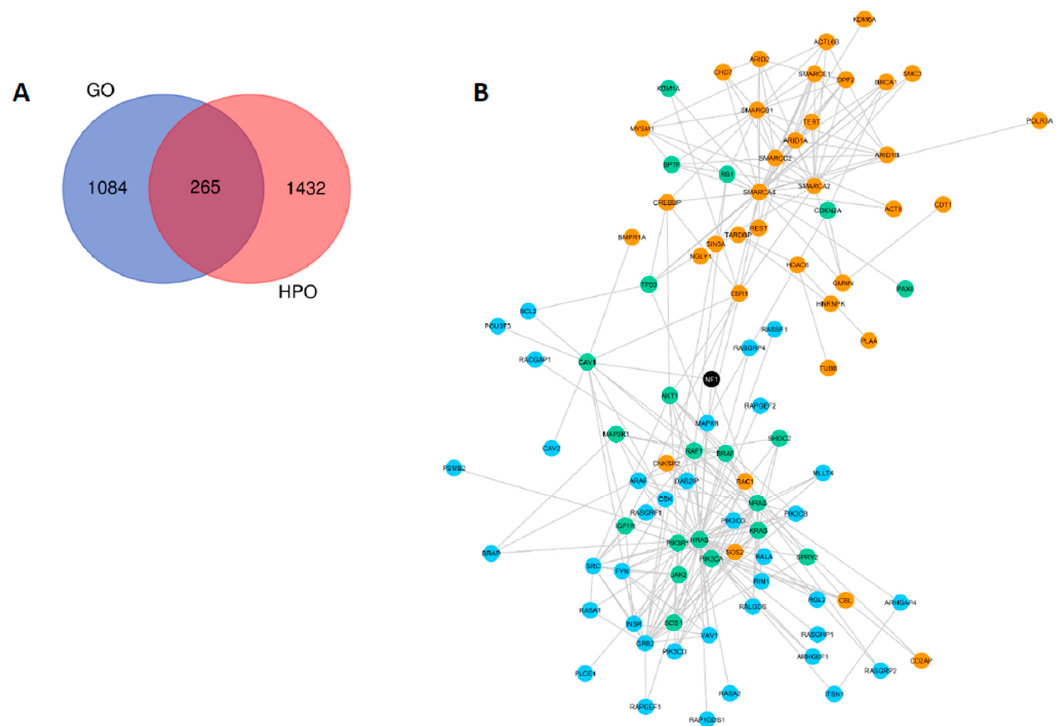
Figure 2. NF1 Gene Ontology (GO) and NF1 Human Phenotype Ontology (HPO) results. ( A ) Venn diagram showing in red genes related with neurofibromatosis type 1 exclusively found by the HPO project in the selected ontologies for NF1; genes exclusively found by the GO consortium using the ontologies selected for NF1 are shown in blue; and in purple genes shared by both GO and HPO analysis. ( B ) A combined network using the STRING tool using the 1697 genes selected exclusively in HPO (orange nodes); 1449 genes selected exclusively in GO (blue nodes); and 265 genes observed in both HPO and GO (green nodes). The network shows only direct protein–protein interactions with NF1 (first neighbors).